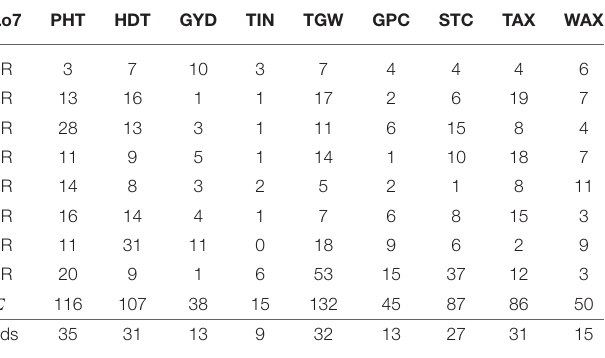
TABLE 5 | Survey on cross-validated marker/trait-associations for agronomic traits, plant height, heading date and grain quality traits mapped in the ‘Lo7’ genome